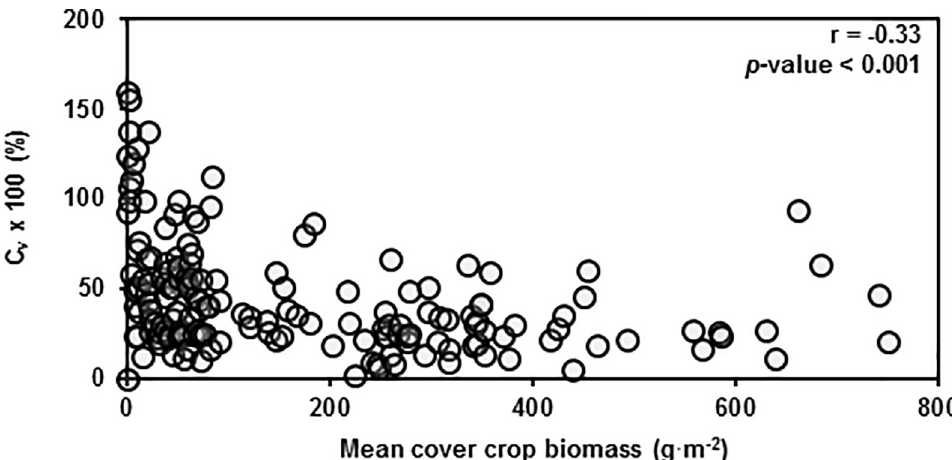
Fig 8. Cover crop coefficient of variation in relation to cover crop biomass. Coefficient of variation of aboveground cover crop biomass across treatments and study sites plotted against mean cover crop biomass. Pearson correlation coefficients (r) also given with p -values for the following test—H 0 : r = 0; H a : r 6¼ 0.